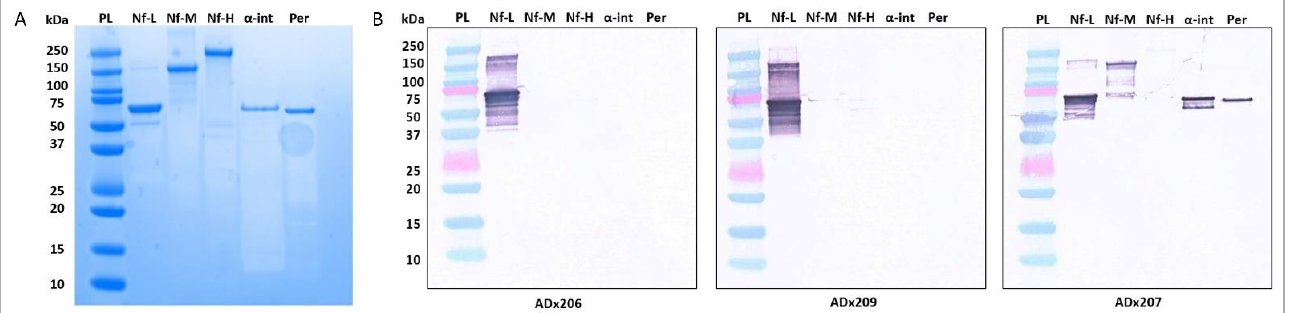
Table 1. OD450 nm – 650 nm values obtained from the indirect ELISA for epitope mapping.